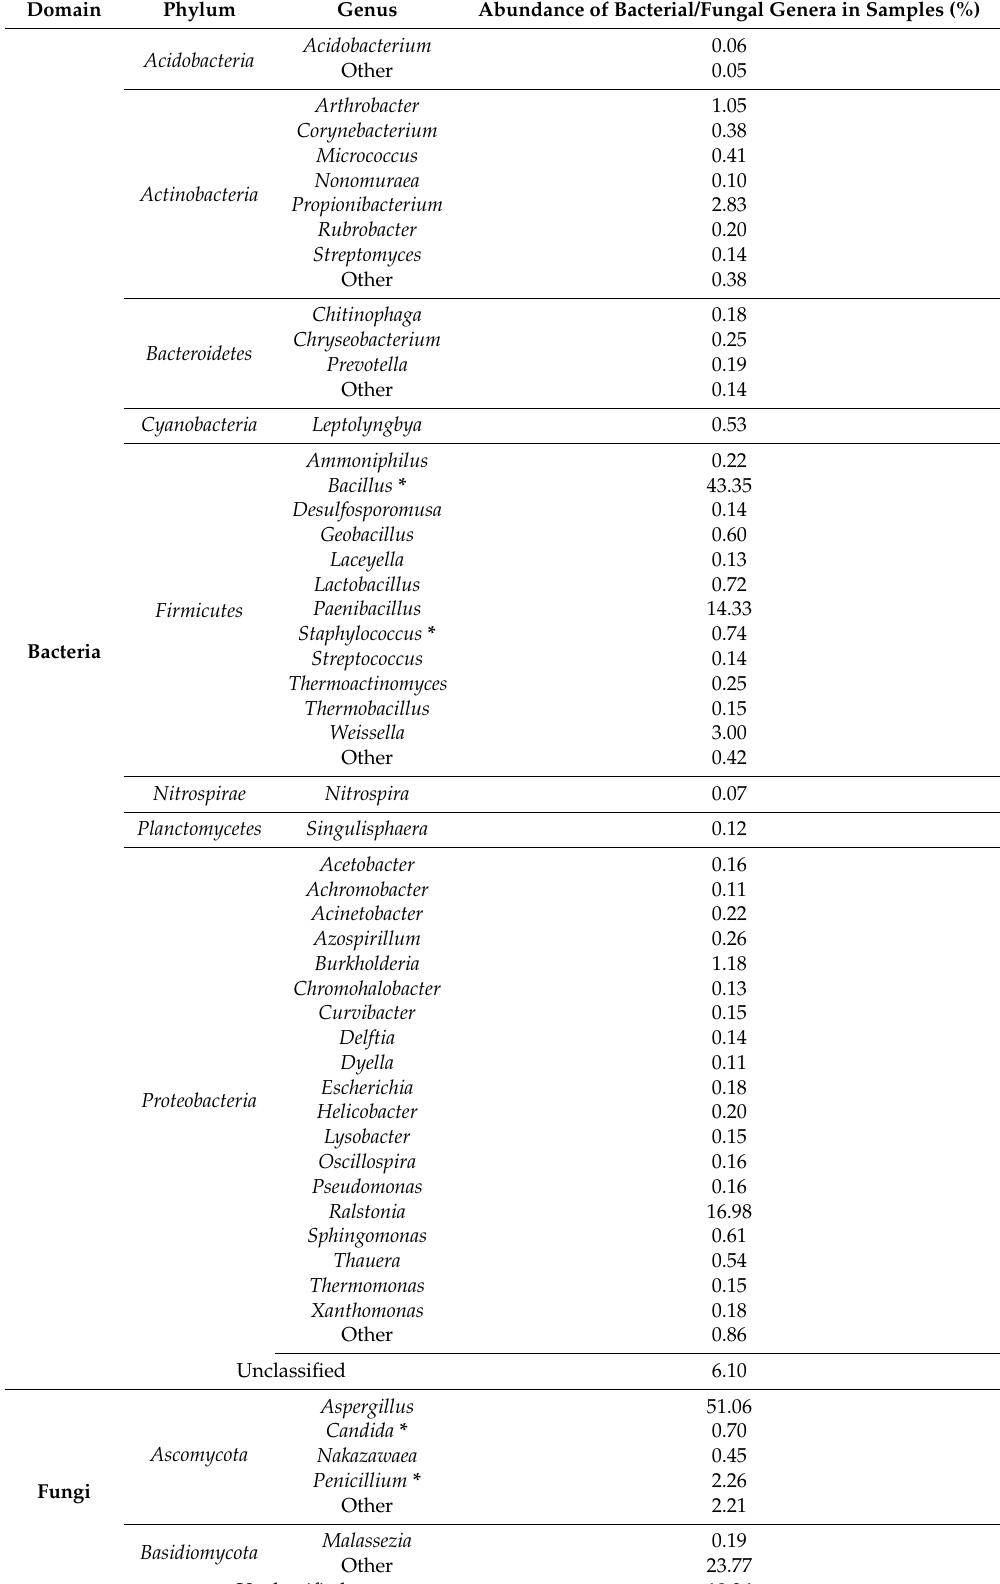
Table 6. The assessment of microbial species composition in FFR